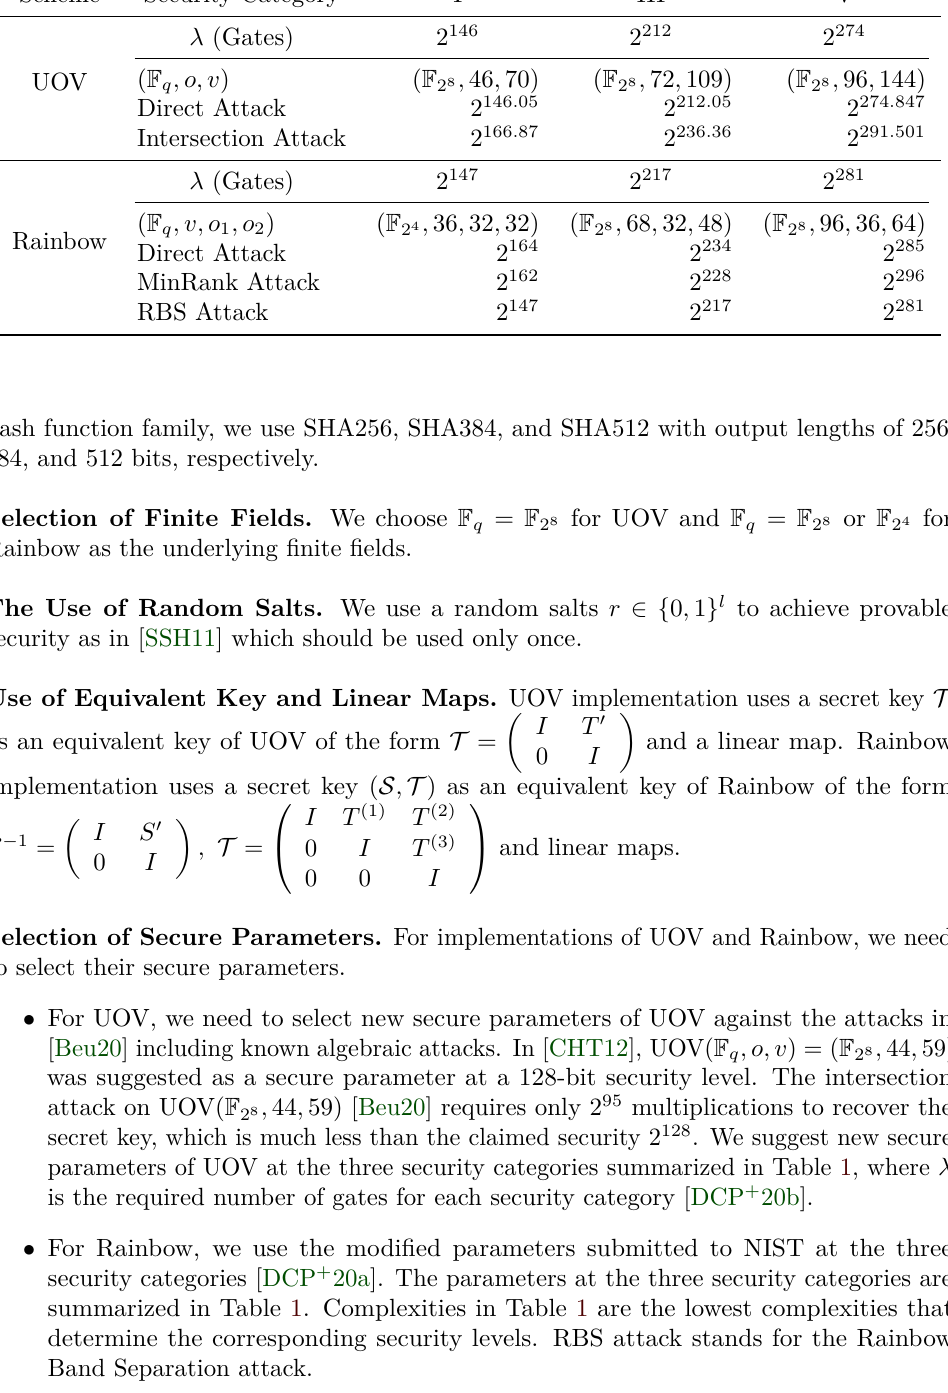
Table 1: Suggested parameters of UOV/Rainbow at three security categories.